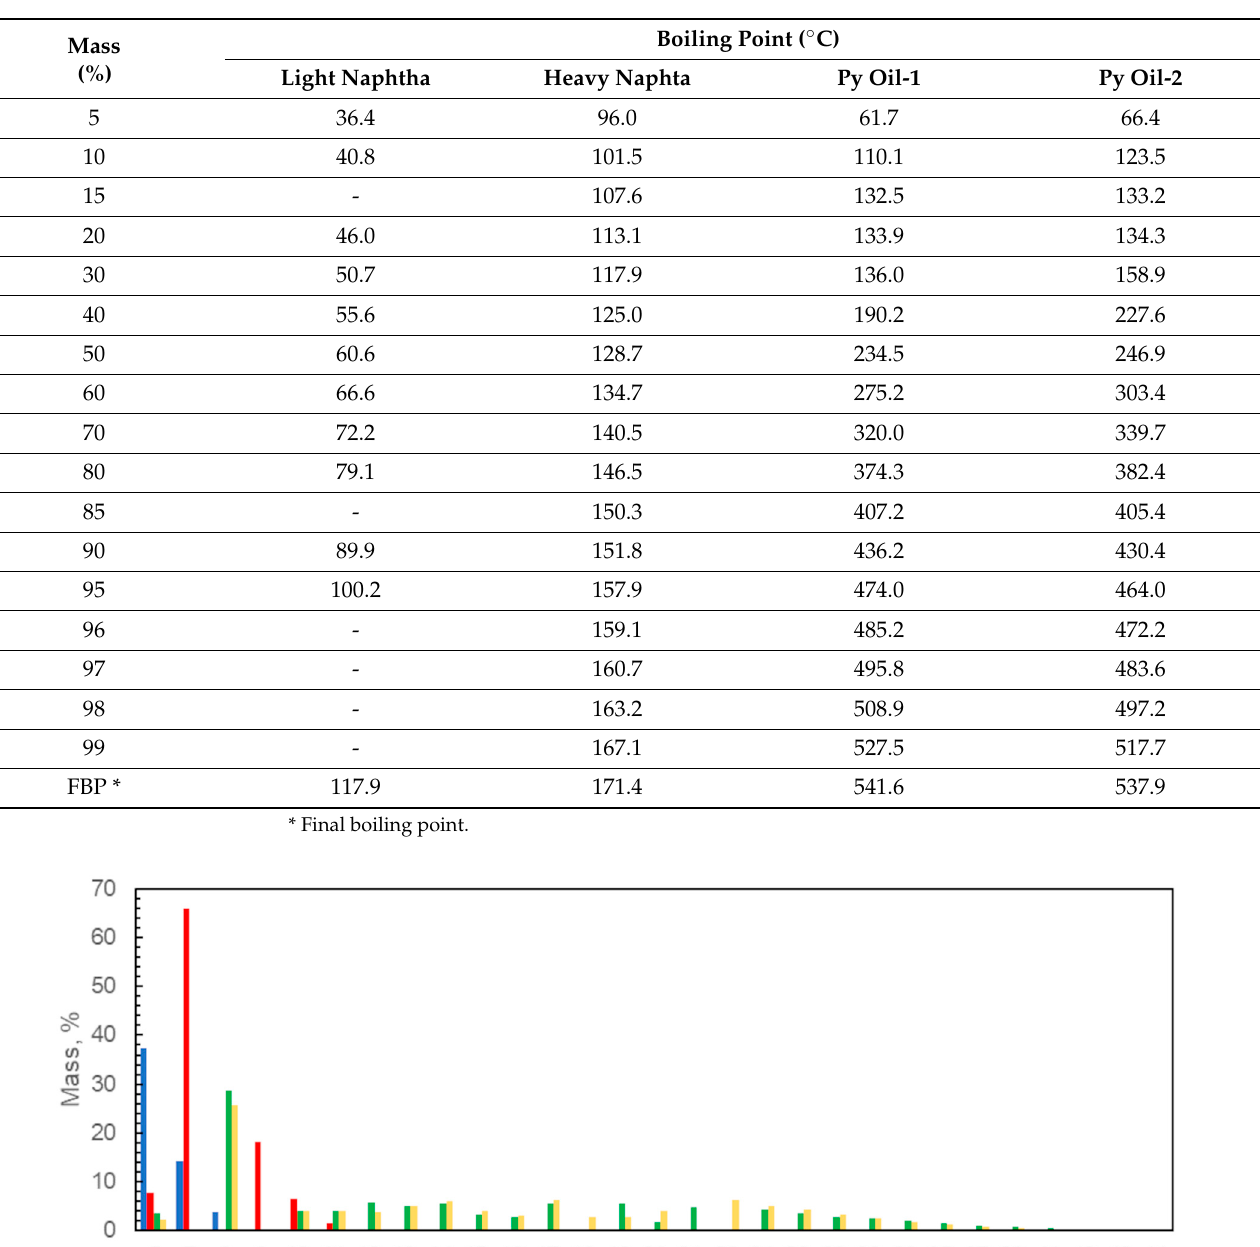
Table 2. SIMDIST analysis results.